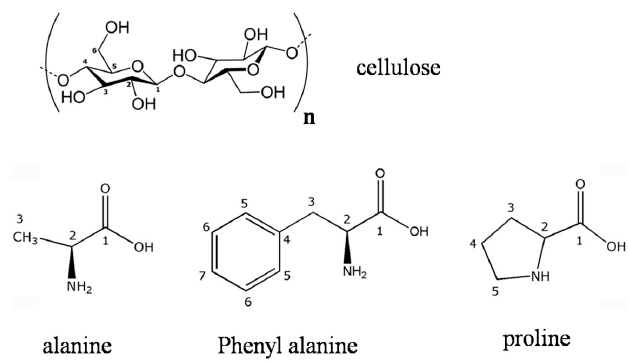
Figure 4. Chemical structure of amino acids and cellulose. Carbon numbering was used for the assignment of the NMR signals (spectra in Figure 3).